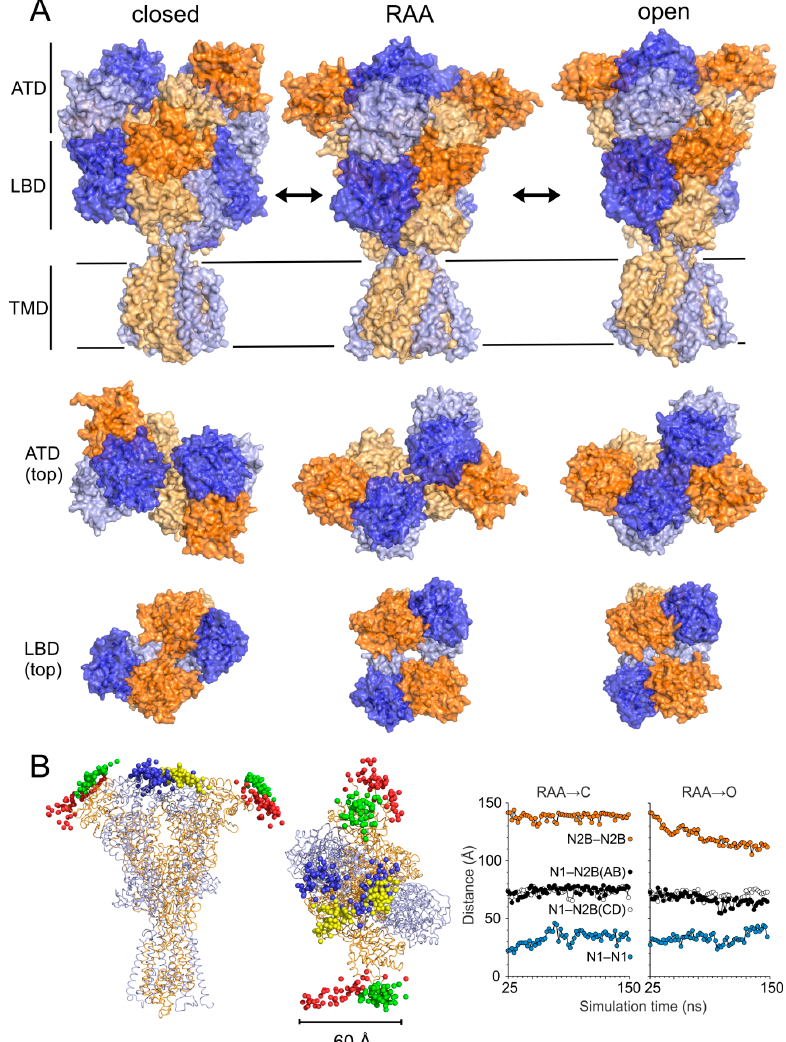
Figure 3. Summary of opening and closing transitions in the NMDAR from MD simulations. ( A ) ( Top ) Side view of the NMDAR showing the structural transition from the closed to the open state of the receptor. The snapshots of geometry from the MD simulation were structurally superimposed using the TMD M3 helices as a reference, keeping the membrane-bound TMD in the same orientation across figures. Different tilt of the outer TMD helices resulting from the iris like movement can be seen. ( Bottom ) The simulation revealed large rearrangement at the level of the ATD and LBD domains during the structural transition between closed and open states. The transition can be described as a rotation of intact ATD and LBD domains from different subunits. The interaction surface of domains changed during the transition as a consequence of the rolling motion. ( B ) ( Left ) Side and top view at the model of NMDAR in the RAA state summarizing the movement of the ATD domains during the opening (green spheres for GluN2B, yellow spheres for GluN1) and closing (red spheres for GluN2B, blue spheres for GluN1) using snapshots of C α atom positions of N-terminal residues. ( Right ) Distances between N-termini of GluN2B–GluN2B ATD (orange), neighboring GluN1–GluN2B ATD (black and white), and GluN1–GluN1 ATD (blue) from the closing MD simulation (left) and opening MD simulation (right). Time 25 ns corresponds to the RAA model. The data show that while the distance between neighboring GluN1 / GluN2B domains remained nearly constant during simulations, rotation of GluN2B domains led to shorter distance between termini during the opening simulation. The panel B summarizes data from a single 150 ns opening and single closing 150 ns